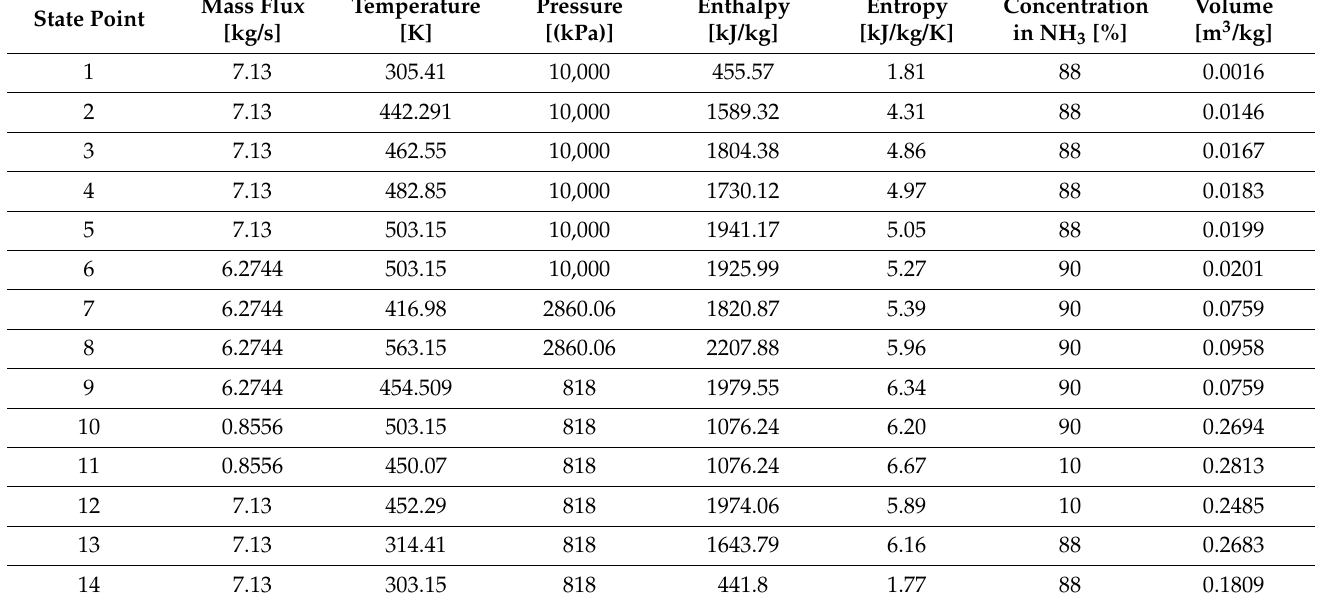
Table 10. Thermodynamic properties of KCC system points.